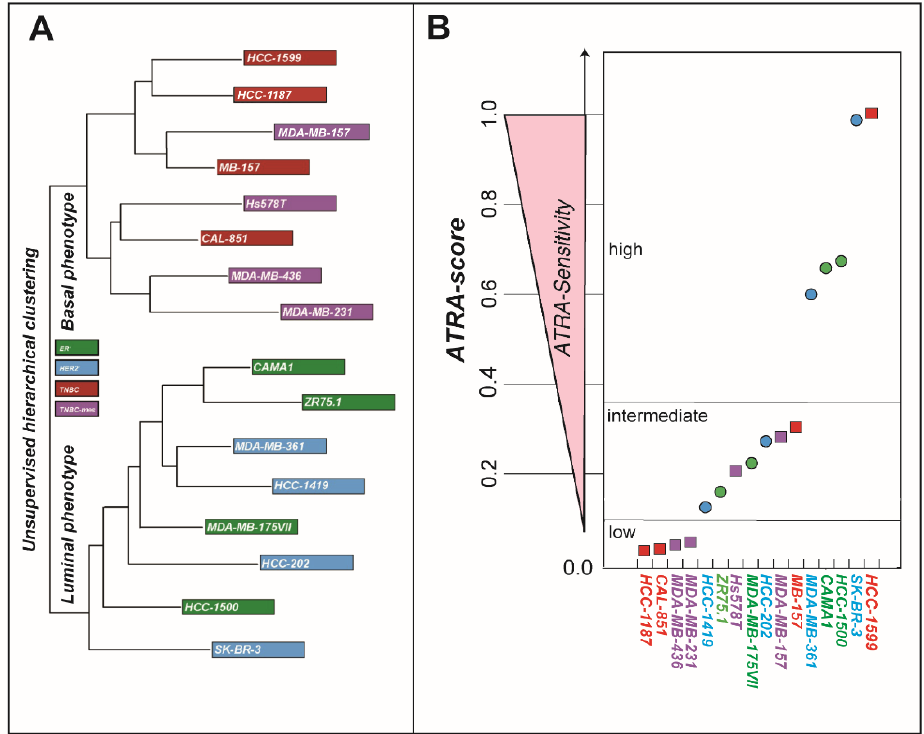
Figure 1. Characteristics and all-trans retinoic acid (ATRA)-sensitivity of the breast cancer cell-lines ( A ) The dendrogram illustrates the unsupervised hierarchical clustering of the indicated 16 breast cancer cell-lines based on the constitutive whole-genome gene-expression profiles determined by RNA-sequencing ( RNA-seq ) analysis. The cell-lines are also classified according to the estrogen receptor, HER2 receptor ( ERBB2 , erb-b2 receptor tyrosine kinase 2) and morphological characteristics into 4 groups: ER + = estrogen receptor positive, HER2 + = HER2 positive, TNBC = triple-negative breast cancer, TNBC-mes = triple-negative breast cancer with a mesenchymal phenotype. ( B ) The indicated cell-lines are ranked according to their sensitivity to the anti-proliferative action of ATRA using the ATRA-score index. The higher the ATRA-score value, the higher the sensitivity of the cell-line to ATRA. Basal cell-lines are indicated with a square, while luminal cell-lines are indicated with a circle. Cell-lines are classified according to a high, intermediate and low sensitivity to ATRA, as shown.